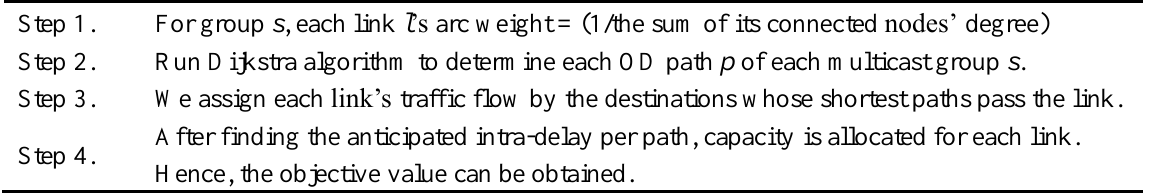
Table 4. Procedures of simple